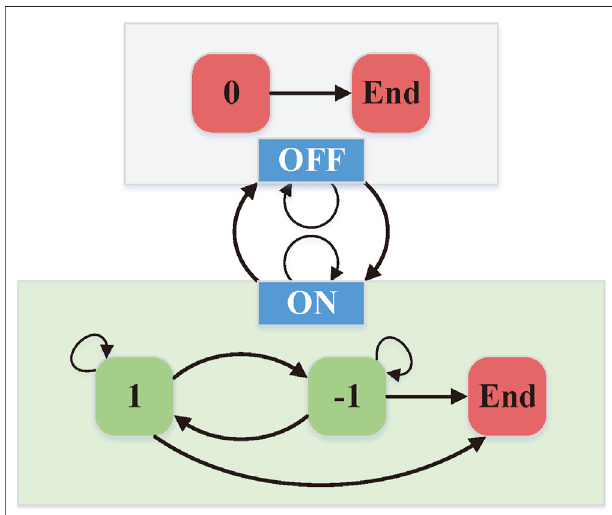
FIGURE2| SchematicdiagramofEVcharging –